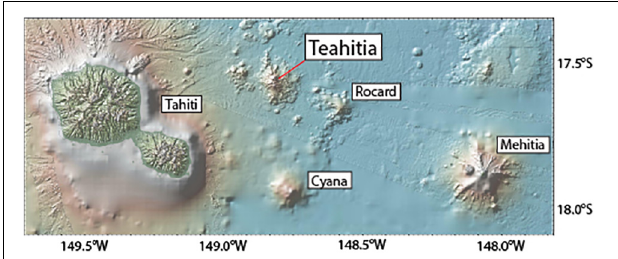
FIGURE 2 | Bathymetric map showing the position of Teahitia Seamount in the context of the currently active portion of the Society Islands hotspot trace which extends for ∼ 100 km from Tahiti to Mehitia (Cheminée et al.,